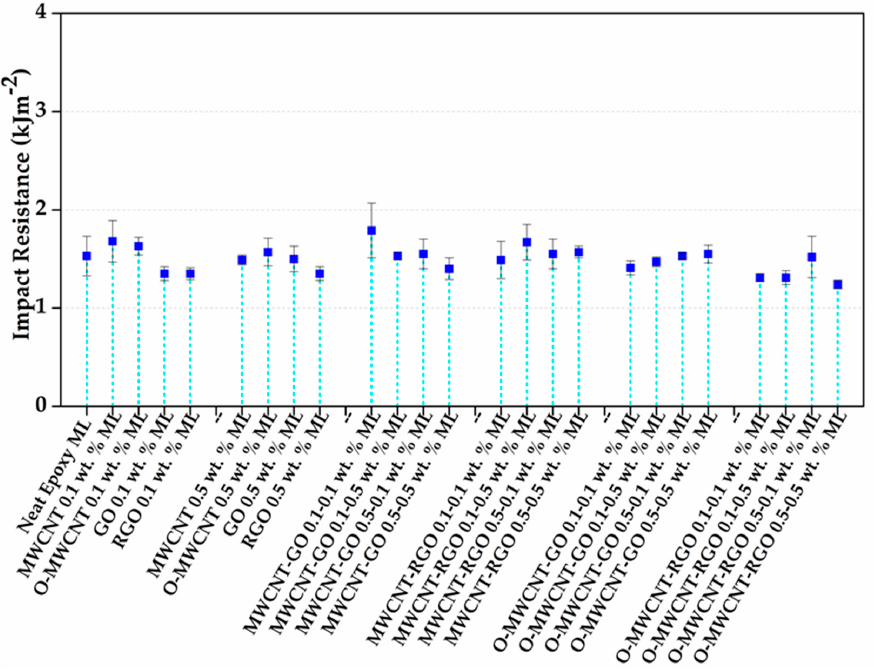
Figure 6. Izod impact resistance values for neat epoxy and multilayer nanocomposites.